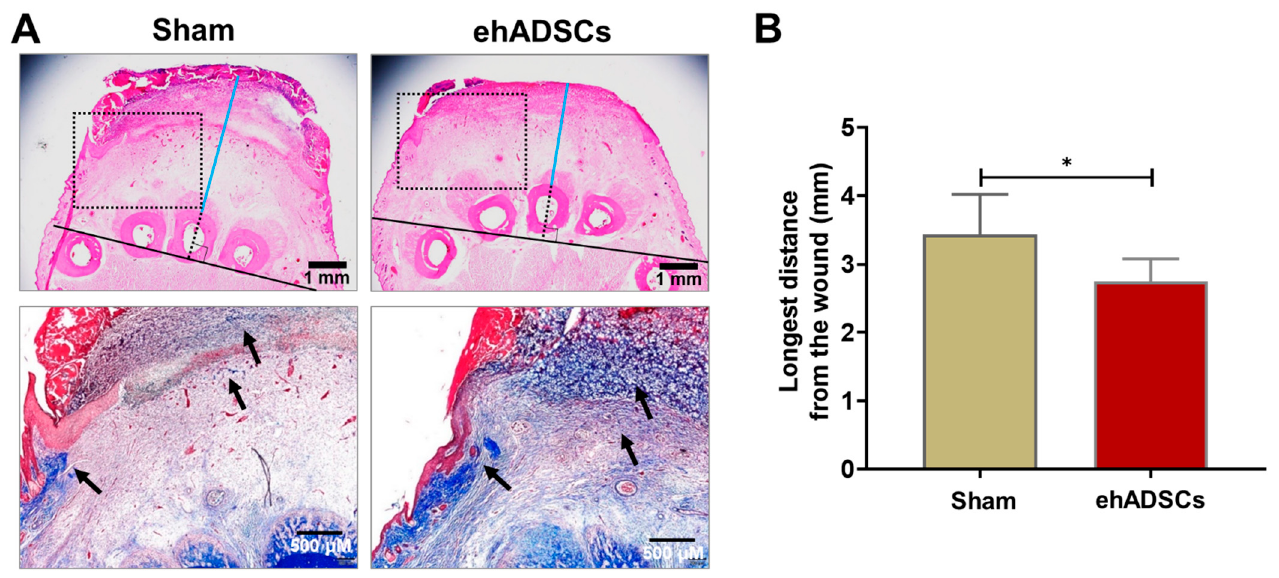
Figure 5. Wound histology. ( A ) Histological evaluation of wounds by H&E (soft tissue thickness between the epidermis and bone is a line drawn horizontally and vertically from the lower end of the animal’s 3rd toe bone and marked in blue from the upper end of the bone to the lower part of the wound) and Masson’s trichrome (dotted rectangle; collagen deposition was stained blue: black arrow) staining at 8 days. A tightly connected tissue structure and greater collagen deposition were observed in the ehADSC group, compared with the sham group. ( B ) The ehADSC group tended to exhibit a shorter bone-epidermis length, compared with the sham group (* p < 0.05).